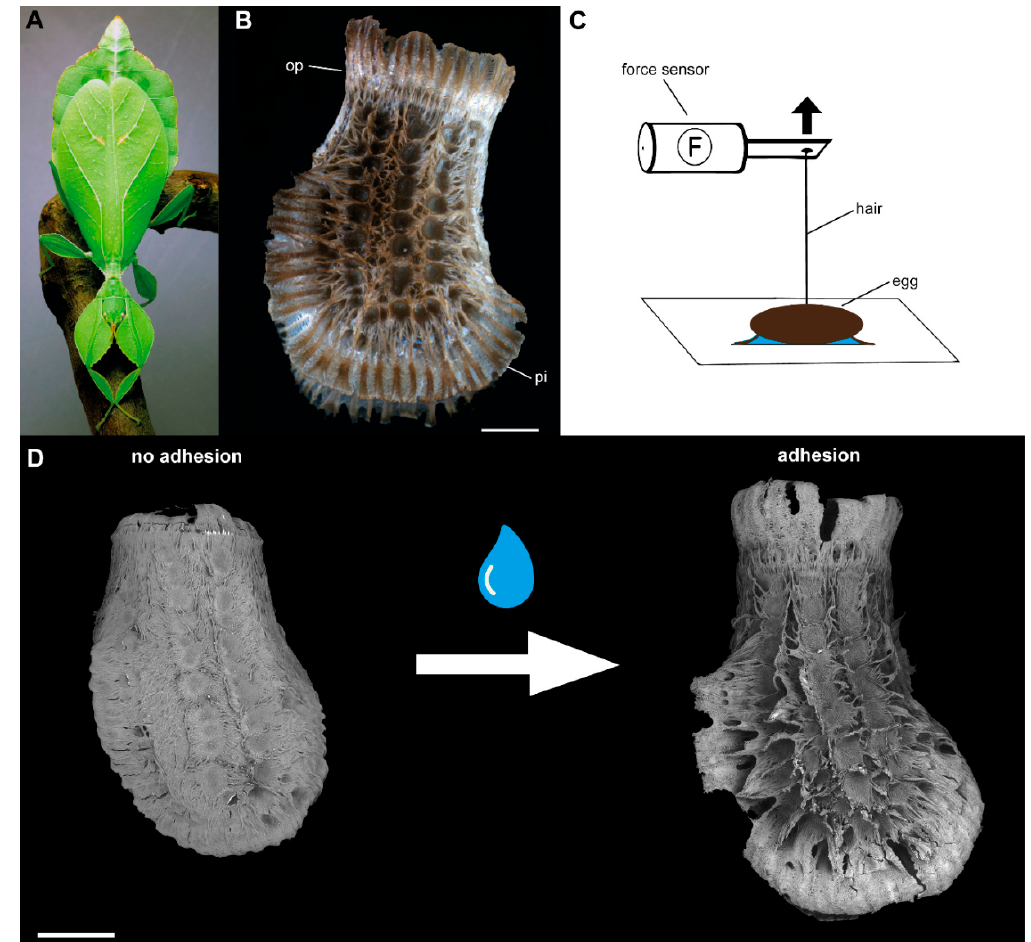
Figure 1. Object of the study and experimental set-up: ( A ) Phyllium philippinicum female, adult (modified from the work in [22], provided by Daniel Dittmar). ( B ) Lateral view of an attached egg. ( C ) Set-up of the experiment. The eggs were pulled off a glass plate in the perpendicular direction and the force was measured with a force sensor attached to the egg (modified from the work in [22]). ( D ) Transition from freshly laid eggs, to functional adhesive eggs with expanded pinnae after contact with water. op, operculum; pi, pinna. Scale bars: 1 mm ( B , D ).